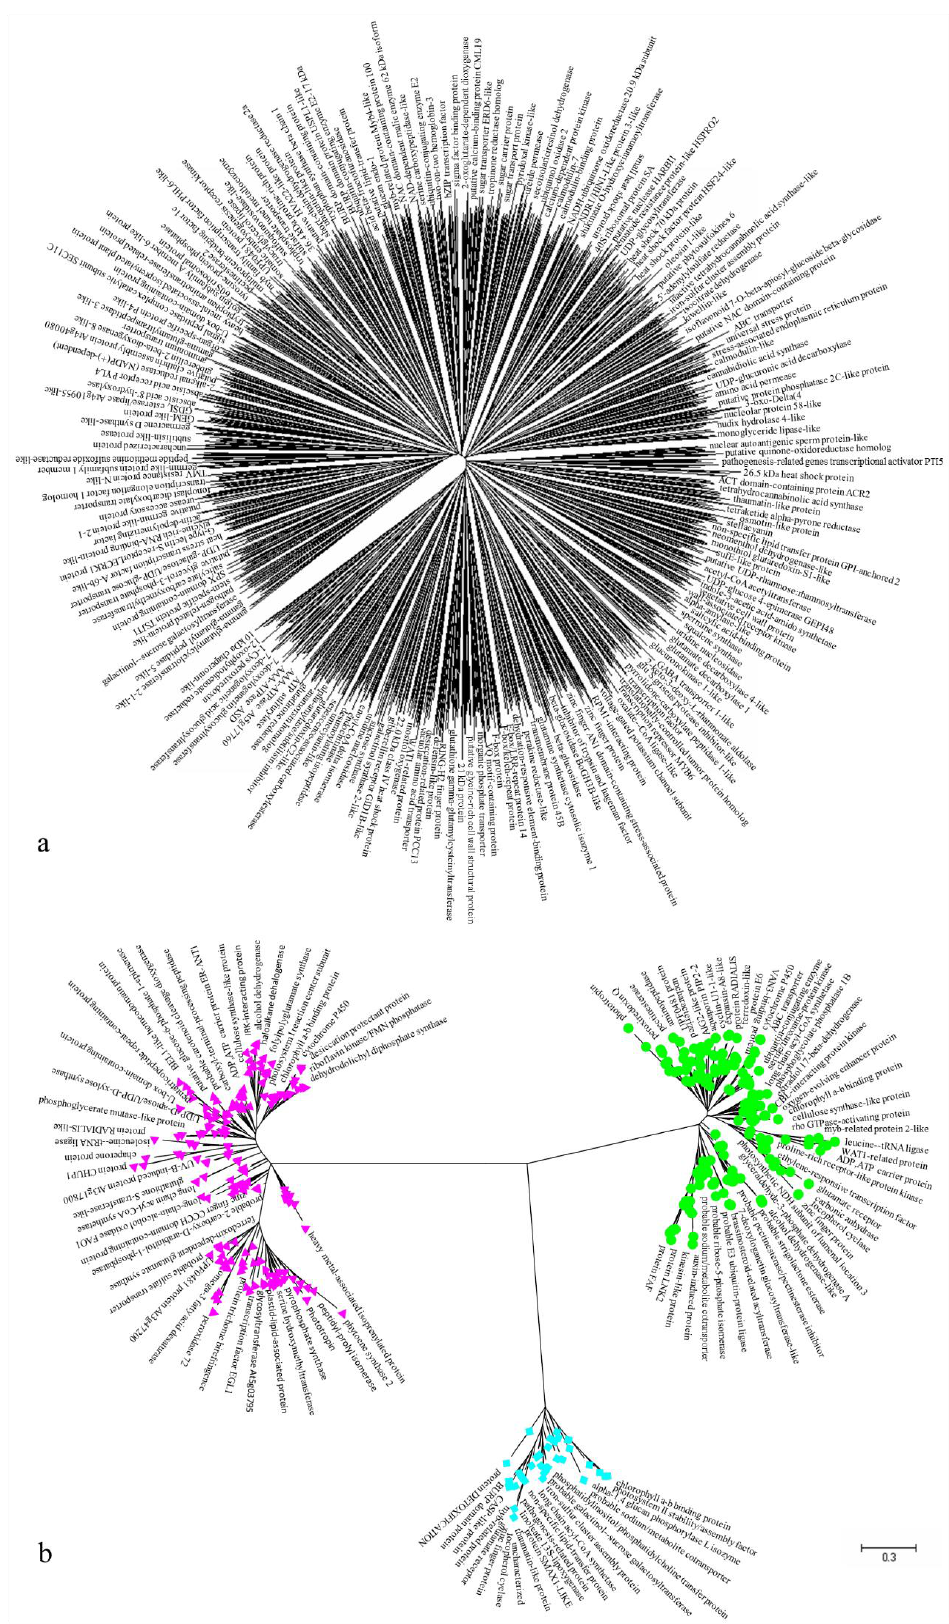
Figure 7. Evolutionary analyses of cluster III ( a ) and cluster X ( b ) conducted with MEGA7. The evolutionary history was inferred using the maximum likelihood (ML) method based on the Tamura–Nei model.